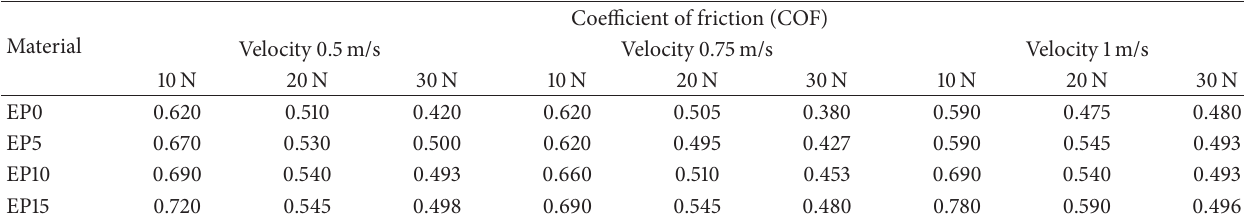
Figure 6: SEM pictures of tensile fractured surfaces. (a) EP0, (b) EP5, (c) EP10, and (d) EP15 samples. Table 4: COF for test samples under different loads and